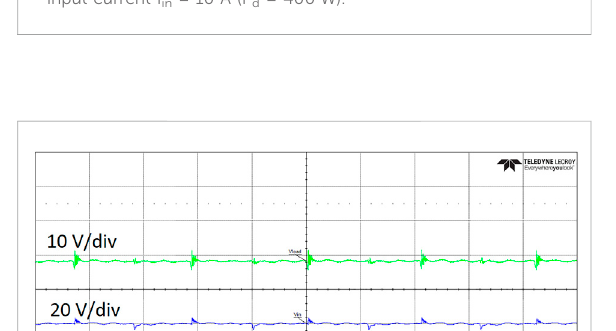
FIGURE 8 Active Load thermal map with input voltage V in = 40 V and input current I in = 10 A (P d = 400 W).